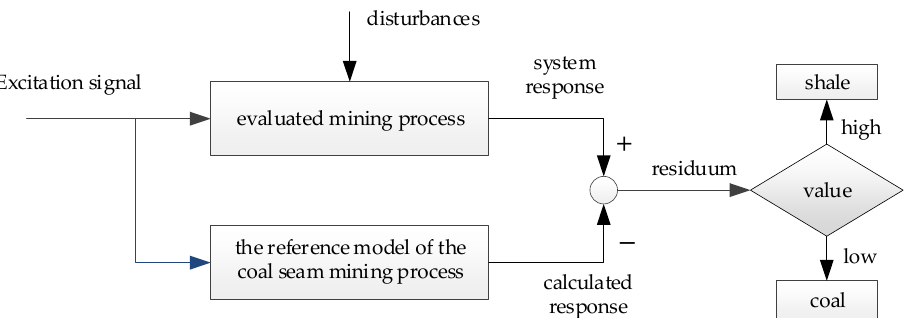
Figure 10. Model of coal and rock recognition.